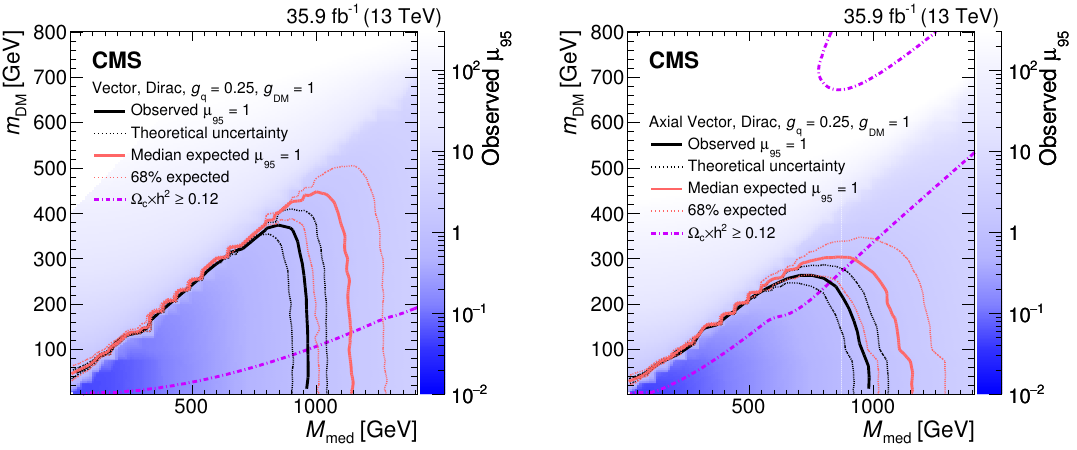
Figure 7 . The ratio of 95% CL upper cross section limits to the theoretical cross section ( (cid:22) 95 ), for DM simpli(cid:12)ed models with vector (left) and axial-vector (right) mediators, assuming g g = 1. Expected (cid:22) 95 = 1 contours are overlaid in red. The region under the observed contour DM is excluded. For DM simpli(cid:12)ed model parameters in the region below the lower violet dot-dash contour, and also above the corresponding upper contour in the right hand plot, cosmological DM abundance exceeds the density observed by the Planck satellite experiment. Figure 8 . The 90% CL exclusion limits on the (cid:31) -nucleon spin-independent (left) and spin- dependent (right) scattering cross sections involving vector and axial-vector operators, respectively, as a function of the m DM . Simpli(cid:12)ed model DM parameters of g The region to the upper left of the contour is excluded. On the plots, the median expected 90% CL curve overlaps the observed 90% CL curve. Also shown are corresponding exclusion contours, where regions above the curves are excluded, from the recent results by CDMSLite [43], LUX [44], PandaX-II [45], XENON1T [46], CRESST-II [47], PICO-60 [48], IceCube [49], PICASSO [50] and Super-Kamiokande [51]